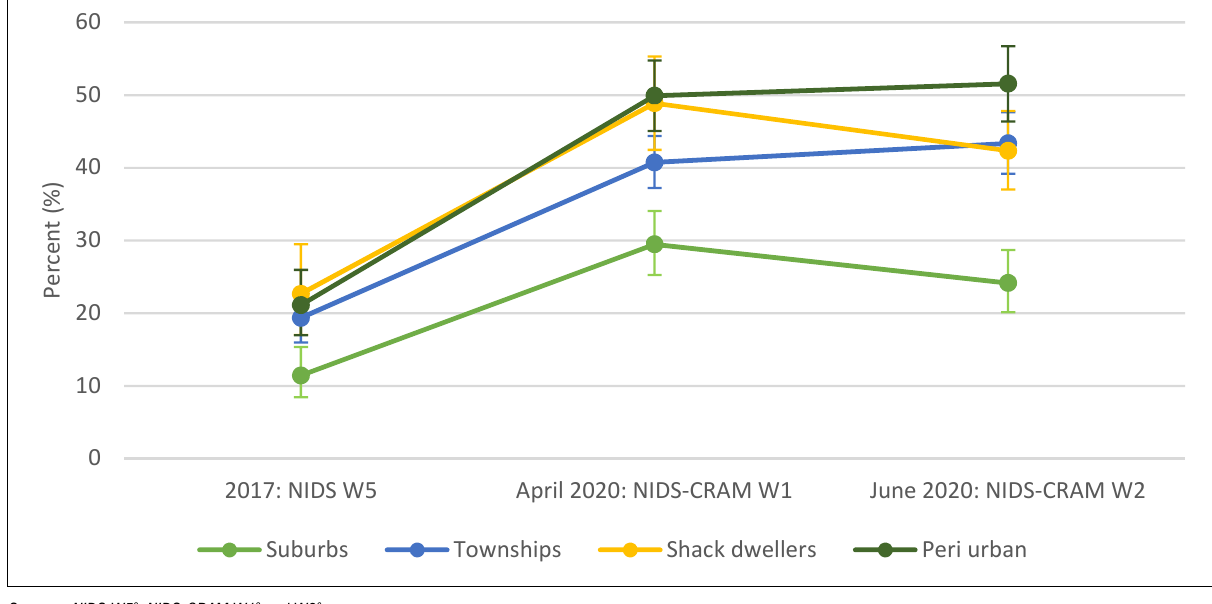
Sources: NIDS W5 8 , NIDS-CRAM W1 2 and W2 6 . Figure 2: Rate of unemployment, 2017 to June 2020.